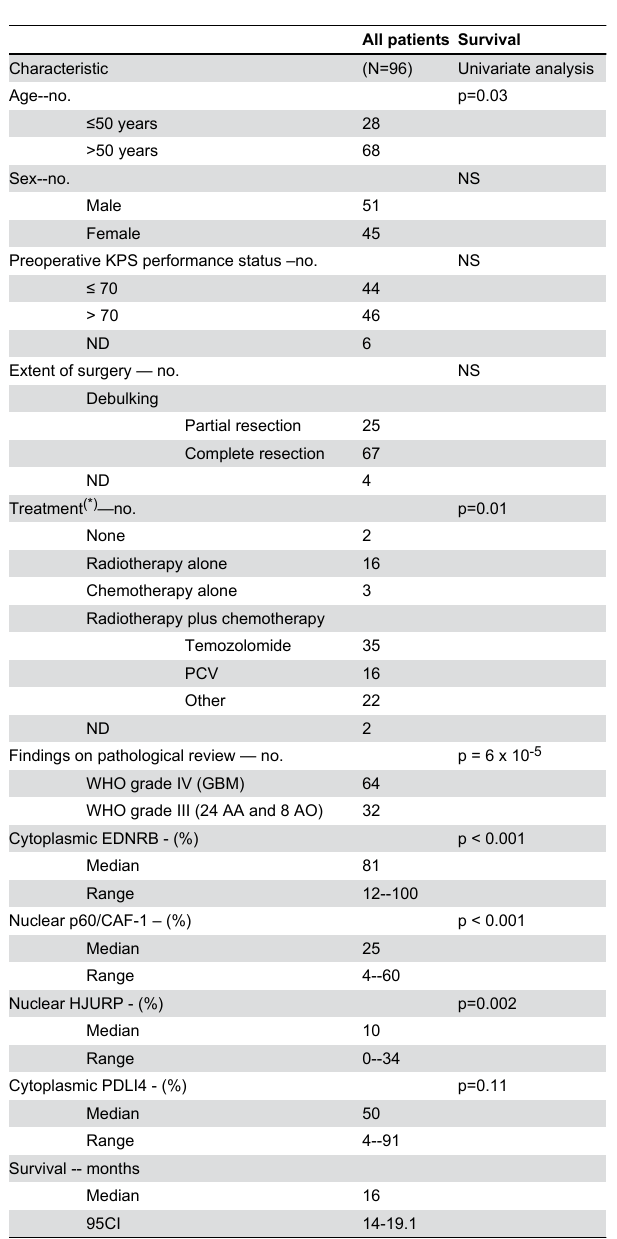
Table 1. Clinical characteristics of the patients and univariate survival analysis.